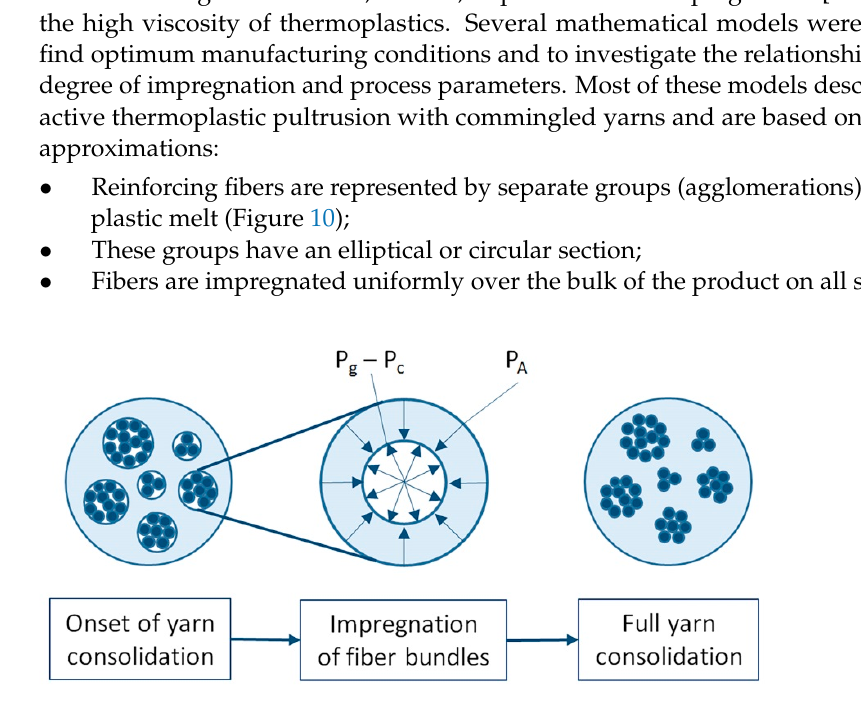
Figure 10. Schematic illustration of yarn section and consolidation process; Pg—pressure from the void, Pc—capillary pressure, P A —applied